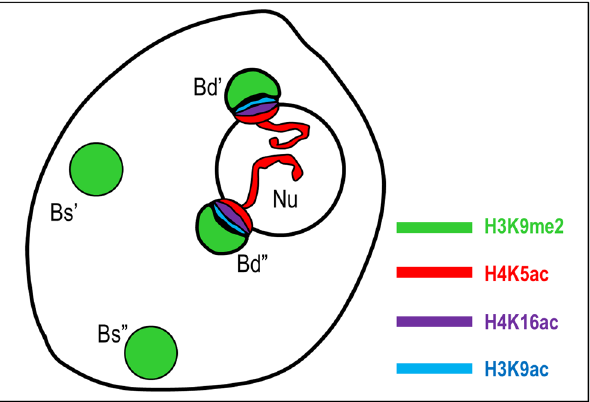
Figure 7. Model of active and silent 35S rDNA loci distribution and their epigenetic status in the nuclei of B. hybridum